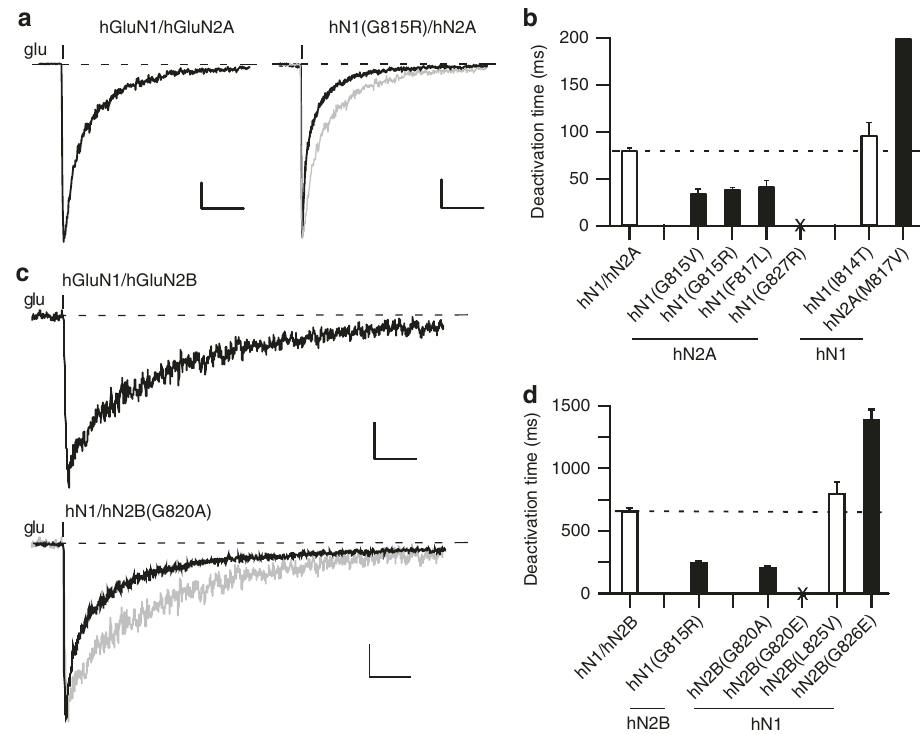
Fig. 2 Missense mutations in M4 segments alter NMDAR gating. a , c Whole-cell currents from HEK293 cells expressing human NMDAR subunits, either hGluN1/hGluN2A ( a ) or hGluN1/GluN2B ( c ) or the same receptor with a missense mutation at the conserved glycine. Currents were elicited by a 2 ms application of glutamate (1 mM) in the continuous presence of glycine (0.1 mM), as approximately occurs at synapses. Gray traces are wild type. Holding potential, − 70 mV. Scale bars: ( a ) 100 pA, wild type; 25 pA, hN1(G815R); ( c ) 50 pA; time base was 0.2 s for all. b , d Bar graphs (mean ± SEM) ( n > 5) showing deactivation rates for hGluN1/hGluN2A ( b ) or hGluN1/hGluN2B ( d ) (Supplementary Table 2). No whole-cell current could be detected for hGluN1 (G827R)/hGluN2A or hGluN1/hGluN2B(G820E), which were tested on at least three different transfection cycles (Supplementary Figure 2). Solid bars indicate values signi fi cantly different from wild type ( p < 0.05, t